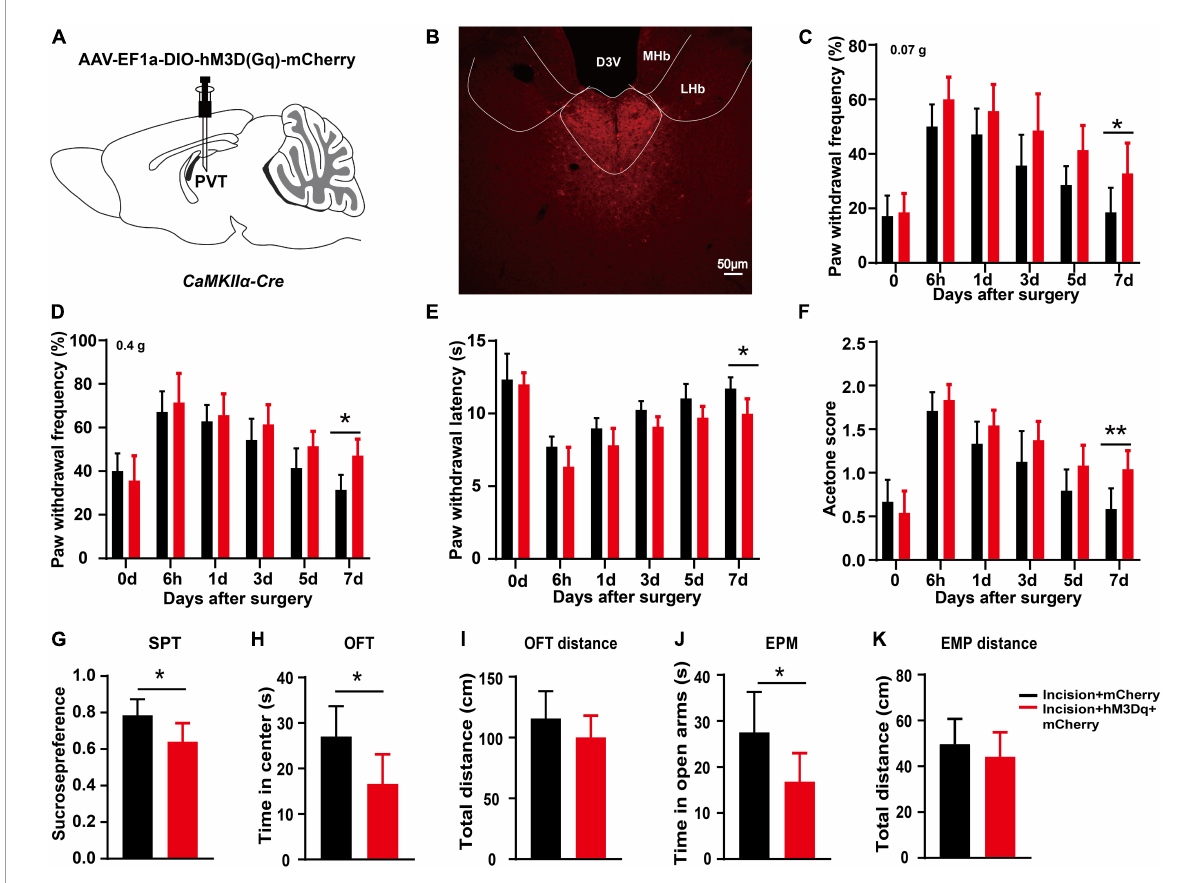
FIGURE5 Chemogenetic activation of middle paraventricular thalamus (mPVT) CaMKII α extended the duration of postsurgical pain. (A) Experimental configuration showing AAV-EF1a-DIO-hM3D(Gq)-mCherry injection into the mPVT of CaMKII α -Cre mice. (B) Representative images of viral expression in the mPVT. (C,D) Mechanical paw withdrawal frequency in response to 0.07 g von Frey (C) and 0.4 g von Frey (D) at different time points. (E) Paw withdrawal latency in response to thermal stimulus at different time points. (F) Measurements of cold sensitivity by acetone testing. (G) Sucrose preference test. (H,I) Open field test [ (H) time spent in the center zone; (I) total distance in the box]. (J,K) Elevated plus maze [ (J) time spent in the open arms, (K) total distance of the maze]. Significance was assessed by two-way ANOVA with post hoc